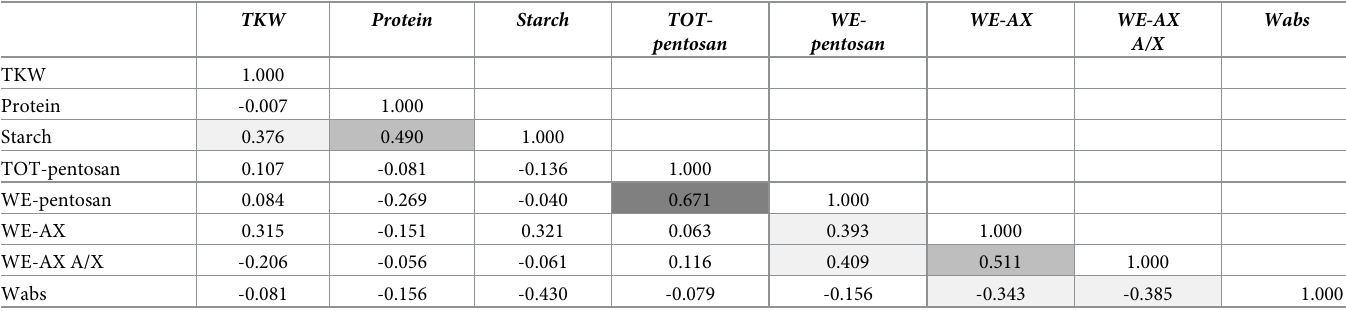
Table 2. Correlation of the coefficient of variation values